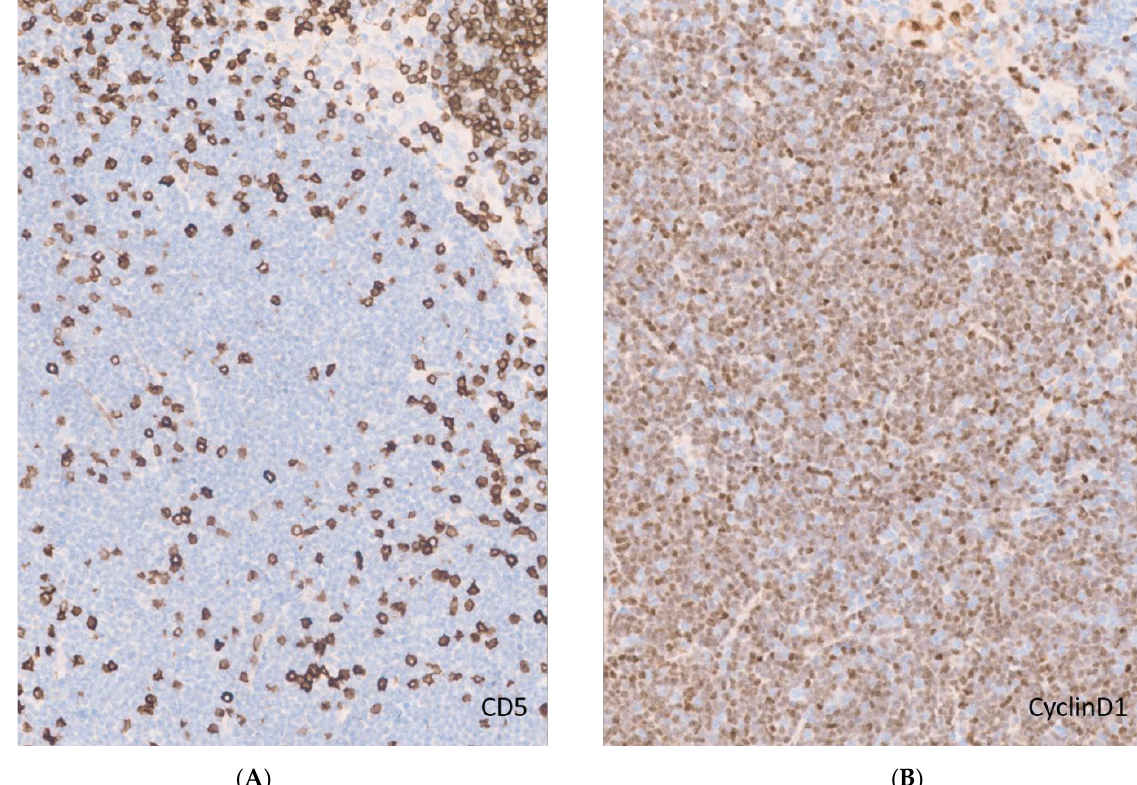
Figure 2. CD5-negative MCL. ( A ). CD5 expression in a lymph node with MCL. Notice the scattered CD5-positive T cells and lack of expression by neoplastic mantle cells (original magnification × 20); ( B ). Cyclin D1 immunohistochemistry demonstrating characteristic diffuse nuclear expression in MCL (original magnification ×